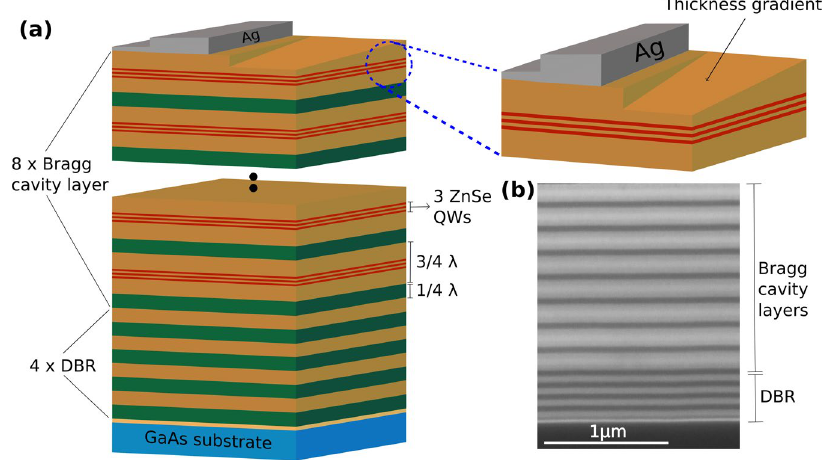
Figure 1. ( a ) Schematic of the investigated Bragg structure. The sample possesses a thickness gradient for the top layer as well as an Ag layer on an area without gradient. ( b ) Scanning electron microscope image of the as- grown Bragg polariton